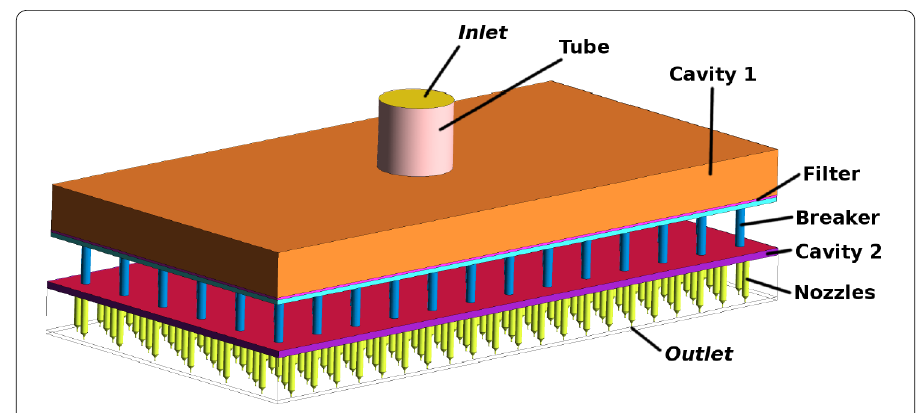
Figure 1 Geometry of the reference spin pack